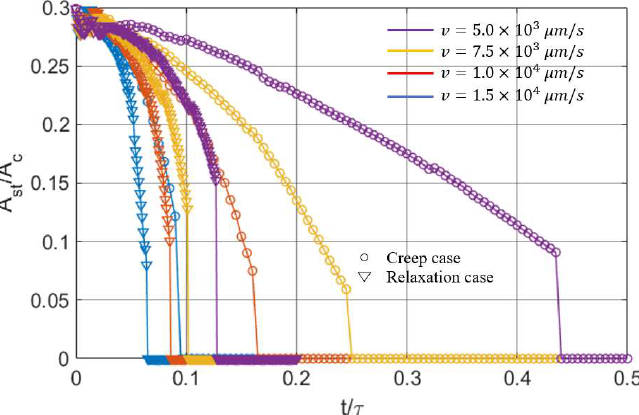
Figure 25. ( a ) Fully coupled solution regarding the variations in the stick ratio with time under dif- ferent increasing rates of displacement and ( b ) Variations in relaxation modulus R ( t ) of the material with time.